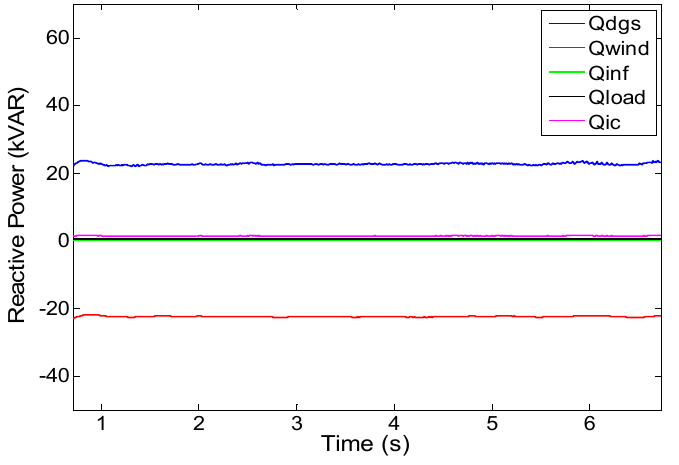
Figure 21. AC reactive power flow in the second case.